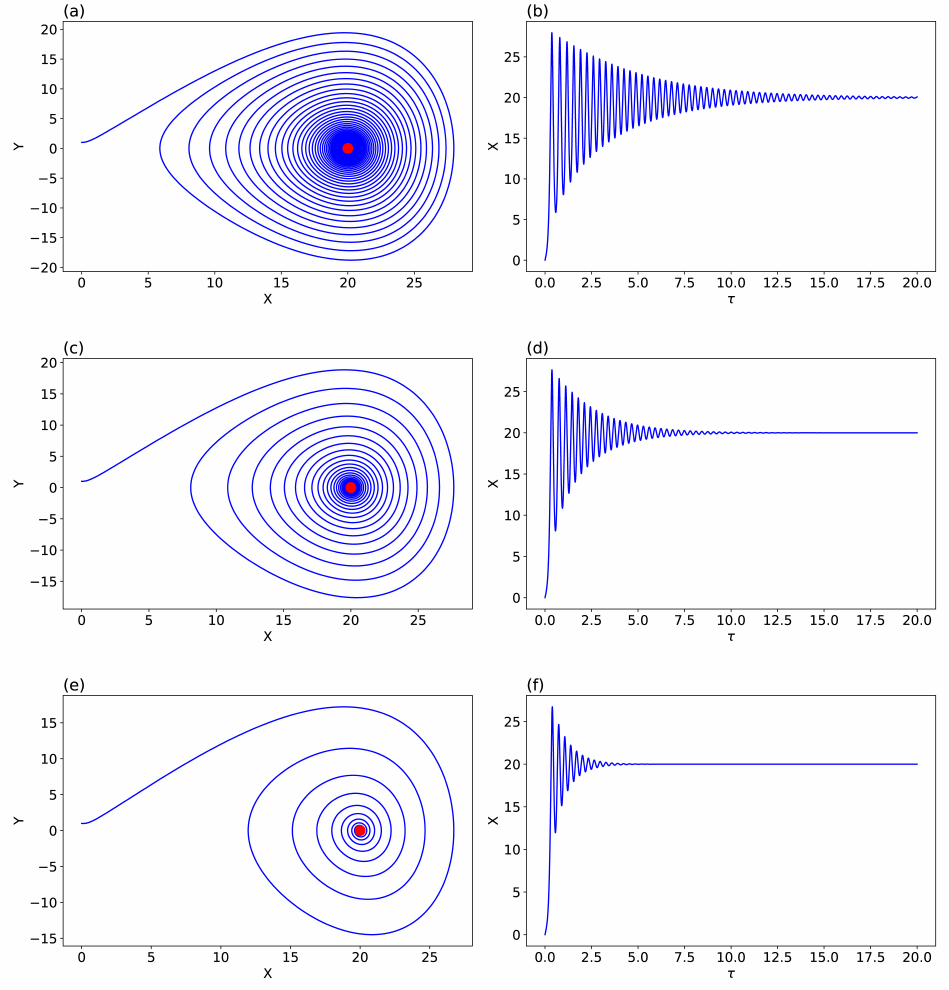
ǫY , and ǫ = 0 . 5 , 1 , − (cid:101) Y , Y space, while right panels depict the − − Y space, −